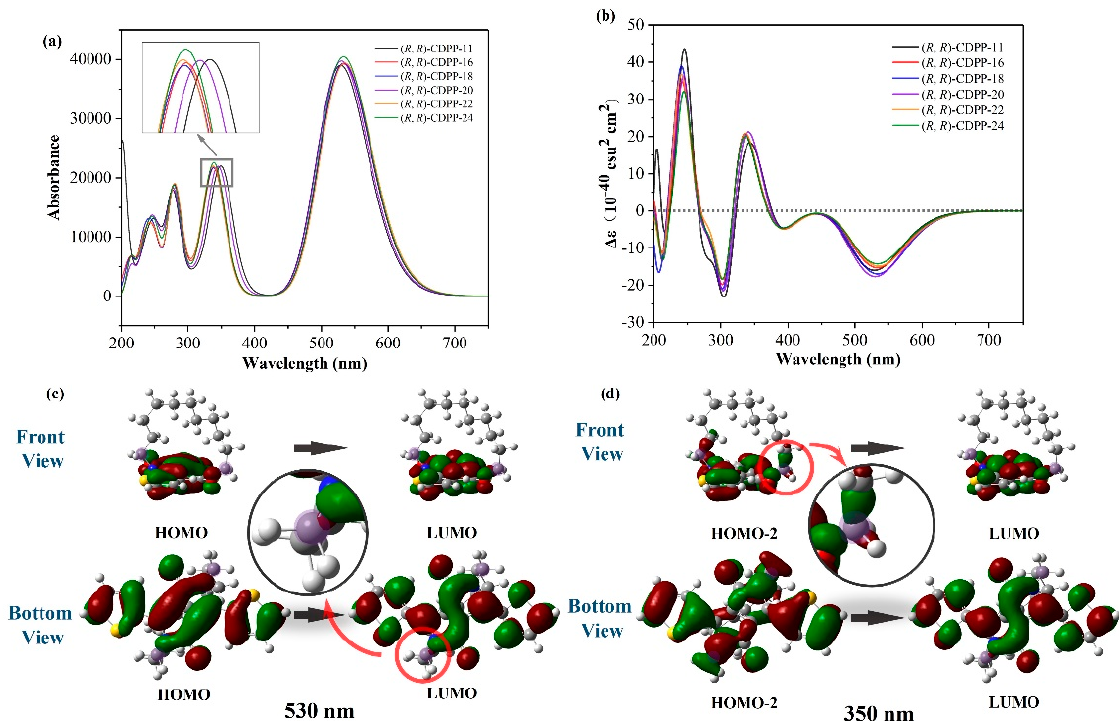
Figure 3. ( a ) calculated absorption spectra of ( R , R )-CDPP molecules; ( b ) calculated ECD spectra of ( R , R )-CDPP molecules; ( c ) the contour surfaces of frontier molecular orbitals (FMOs) involved in the absorption peak of ( R , R )-CDPP-11 at 530 nm; and ( d ) the contour surfaces of FMOs involved in the absorption peak of ( R , R )-CDPP-11 at 350 nm. The chiral centers are highlighted with light pur- ple.